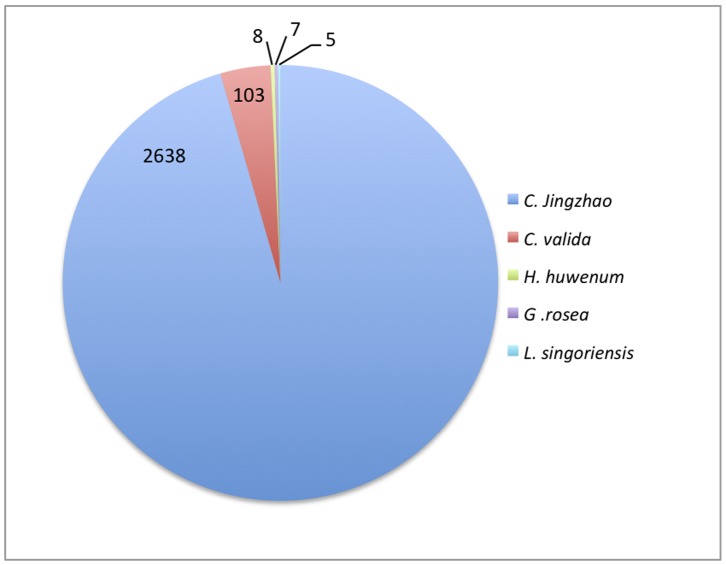
Pie chart showing the relative number of top BLAST hits from Selenotypus plumipes sequences to toxins of different species from the ArachnoServer database.Numbers represent the counts of S.plumipes sequences that match known toxins from species, including Chilobrachys jingzhao (Chinese earth tiger tarantula), Coremiocnemis valida (Singapore brown tarantula), Haplopelma huwenum (Chinese bird spider), Grammostola rosea (Chilean rose tarantula), and Lycosa singoriensis (wolf spider). With the exception of L.singoriensis, all of these spiders are primitive mygalomorphs that are closely related to S. plumipes.